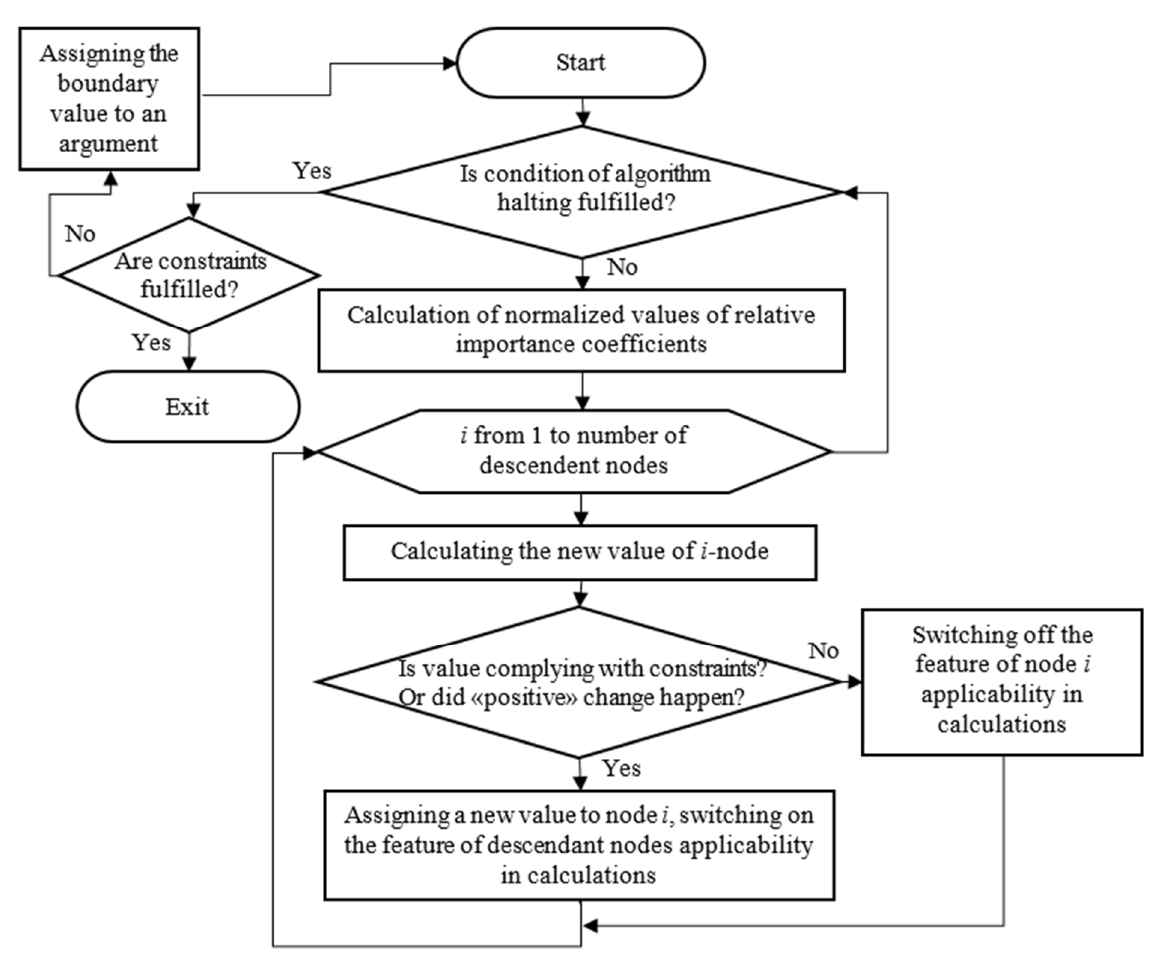
Figure 4. Algorithm for solving the inverse problem.